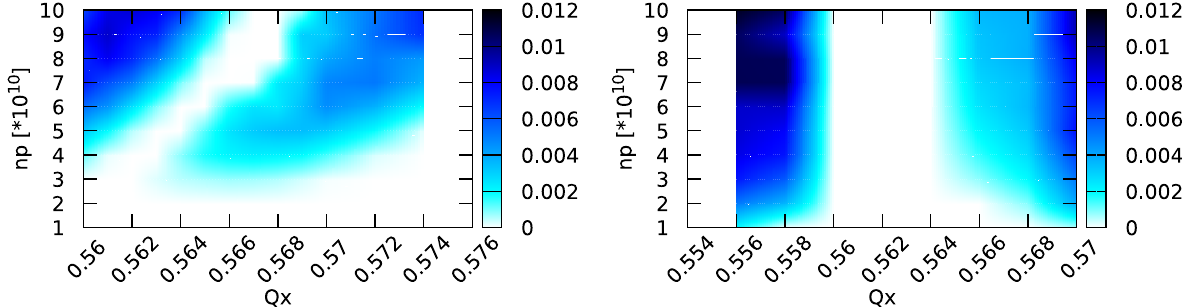
FIG. 8. Growth rate of horizontal beam size during bootstrapping injection for different tune. The left/right figure is for the case with and without impedance